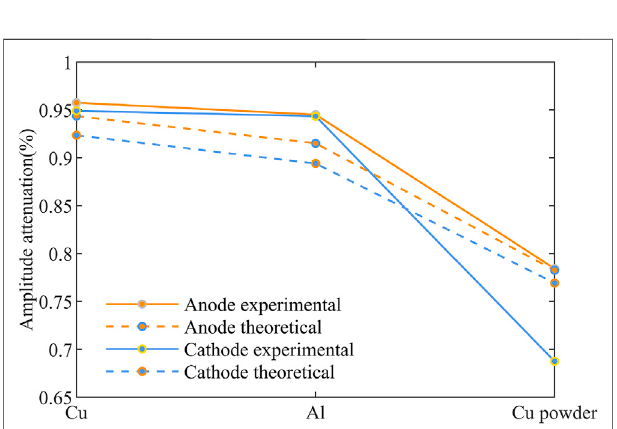
FIGURE 12 | Experimental and theoretical comparison of transmittance changes caused by different defects.